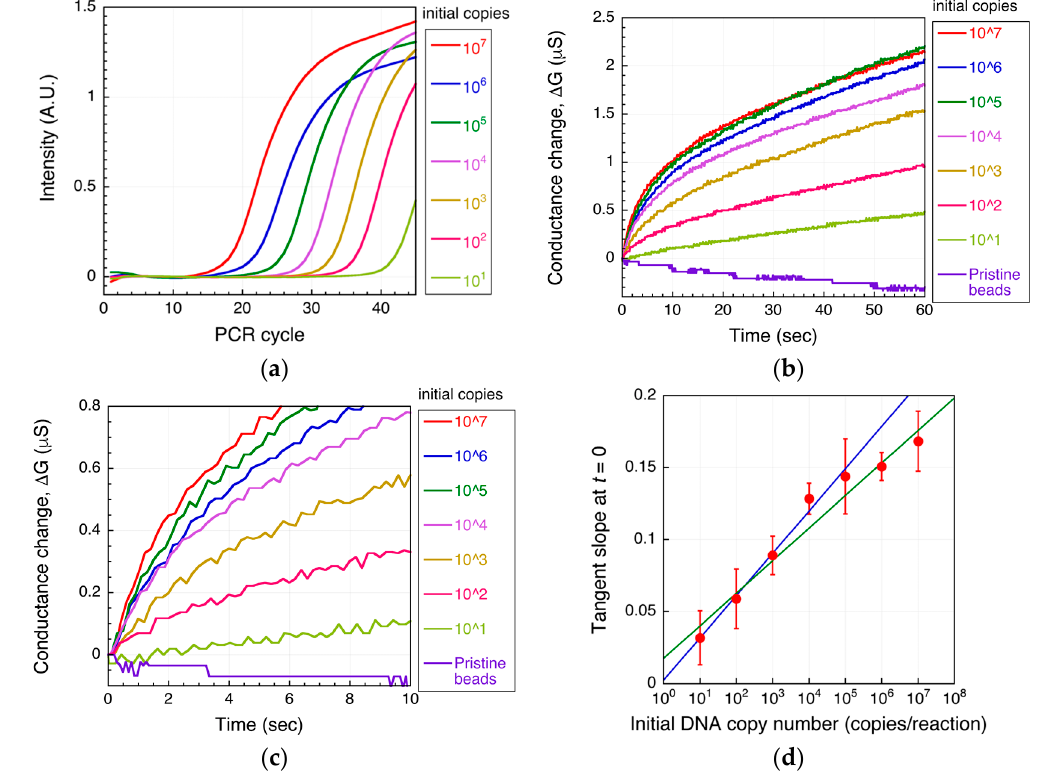
Figure 4. DNA detection using the microbead DEP-based method. Shown are the real-time PCR intensity curve ( a ), the changes in conductance using amplicons of ( a , b ), and the initial tangent slope ( d ) for each initial target DNA copy number. A magnification around t = 0 of ( b ) is shown in ( c ). In ( d ), mean values are shown; errors bars are the standard deviation from three independent experiments. The blue solid line is the fitted line in the range of 10 to 10 5 copies ( R 2 = 0.988). The green solid line is the fitted line in the range from 10 to 10 7 copies ( R 2 = 0.954).